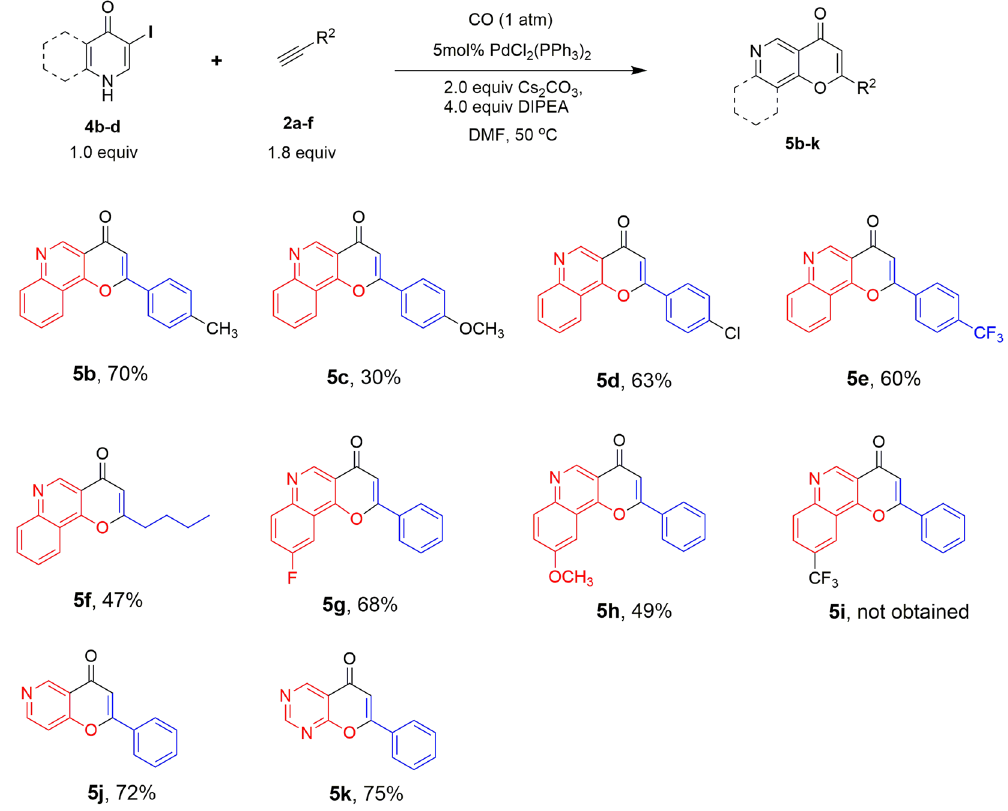
Figure 7. Synthesis of compounds 5b–5k . a Reaction condition: 4 (0.2 mmol), 2 (1.8 equiv), PdCl 2 (PPh 3 ) 2 (5 mol %), 2.0 equiv